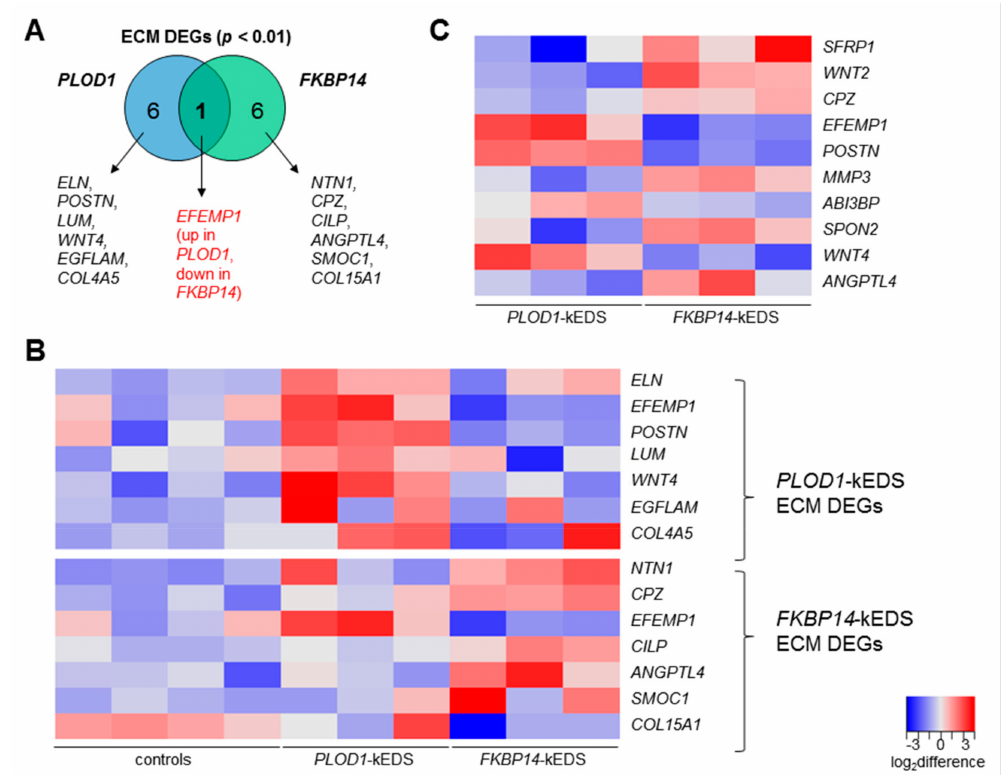
Figure 2. ( A ) Venn diagram depicting unique DEGs contributing to the enrichment of ECM in PLOD1 -kEDS and FKBP14 -kEDS patient-derived fibroblasts versus controls. ( B ) Heatmap depicting expression levels of DEGs encoding ECM components per subject. Top panel consists of genes that are di ff erentially regulated in PLOD1 -kEDS versus controls. Bottom panel consists of genes that are di ff erentially regulated in FKBP14 -kEDS versus controls. ( C ) Heatmap depicting expression levels of ECM genes that are significantly di ff erent between PLOD1 -kEDS and FKBP14 -kEDS. The colors indicate the log 2 di ff erence relative to the average expression of all samples within the